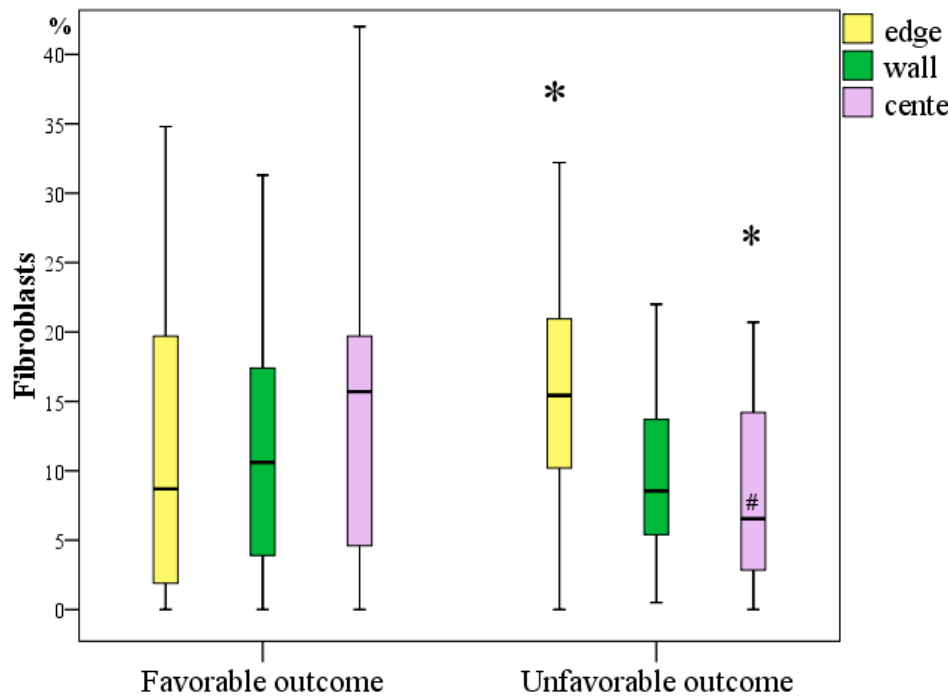
Figure 6. Frequency of occurrence of fibroblasts in chronic diabetic foot wounds with different outcomes on Day 1 during primary surgical treatment (*—difference between groups in terms of outcome at p < 0.05, Mann–Whitney U test; #—a significant increase in the number of cells relative to their content in the centre of the wounds within one outcome subgroup at p < 0.05, Friedman test).